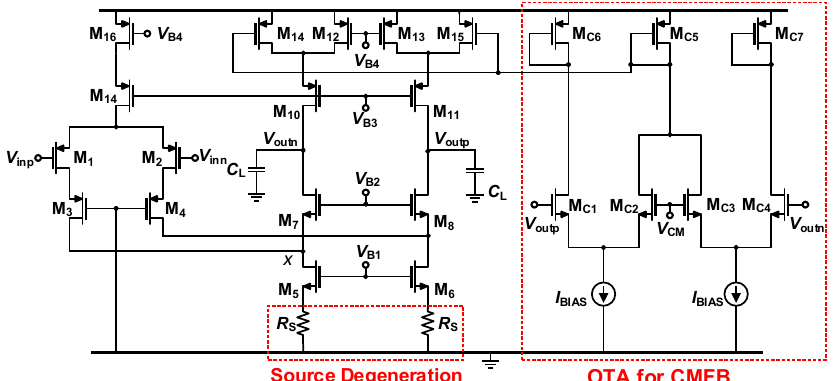
Figure 1. A folded cascode operational transconductance amplifier (FC-OTA) for neural recordings with a conventional differential-difference amplifier-based common-mode feedback (CMFB).